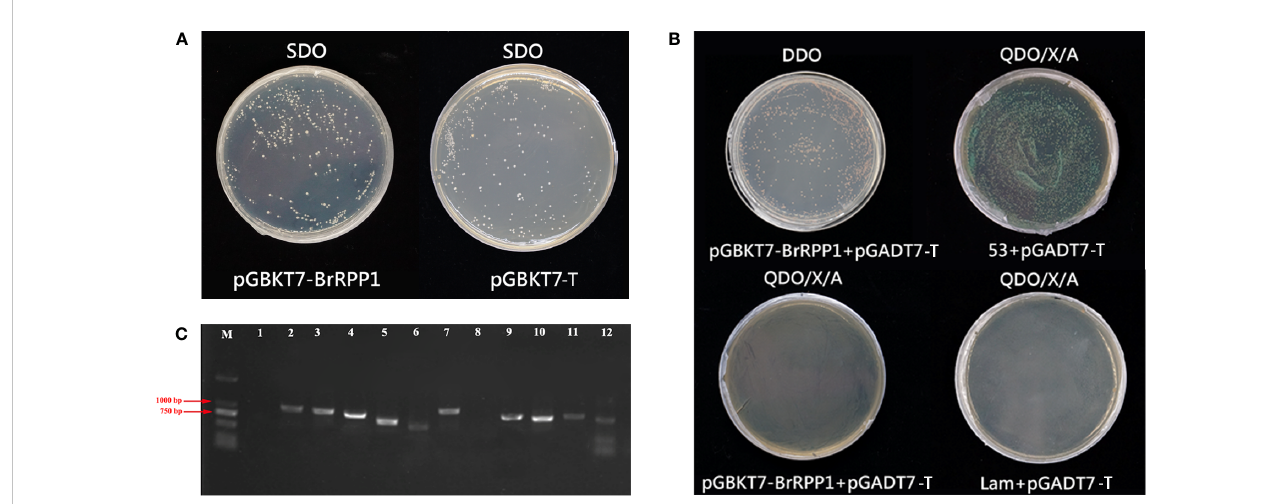
FIGURE 6 Interaction proteins screening of pGBKT7-BrRPP1. (A) Toxicity test of pGBKT7- BrRPP1. (B) Self-activation detection of pGBKT7- BrRPP1. (C) PCR identi fi cation of positive interaction proteins of BrRPP1